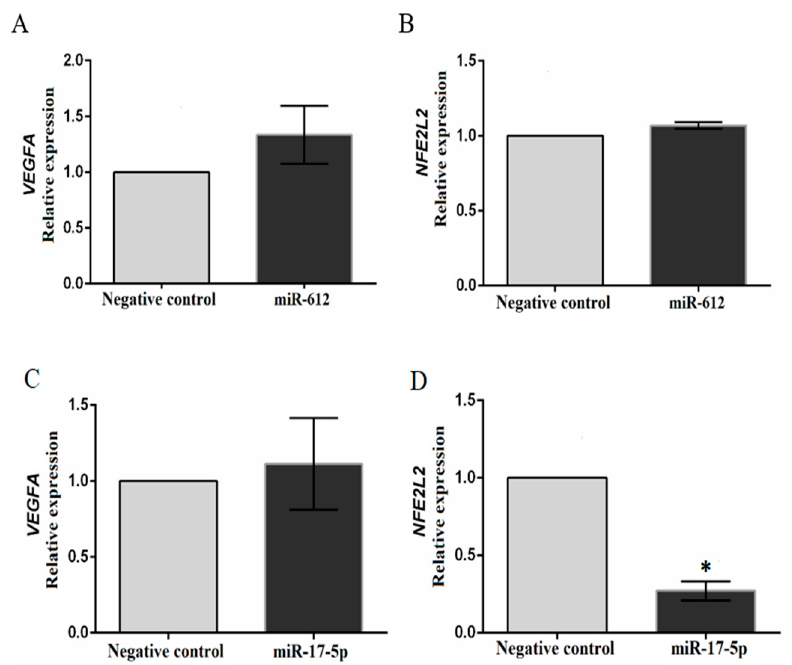
Figure 5. Results of the transfection assay on the TPC-1 cell line using mirVana ™ miRNA Inhibitor for miR-17-5p, and mirVana ™ miRNA Mimic for miR-612. VEGFA expression did not di ff er between cells transfected and non-transfected with miR-612 ( A ) and the inhibitor for miR-17-5p ( C ). NFE2L2 expression did not di ff er between cells transfected and non-transfected with miR-612 ( B ); the inhibition of miR-17-5p resulted in approximately 73% inhibition of NFE2L2 expression ( D ). *, approximately 73% inhibition of gene expression in relation to the negative control. Calibrator (negative control) log RQ = 1.